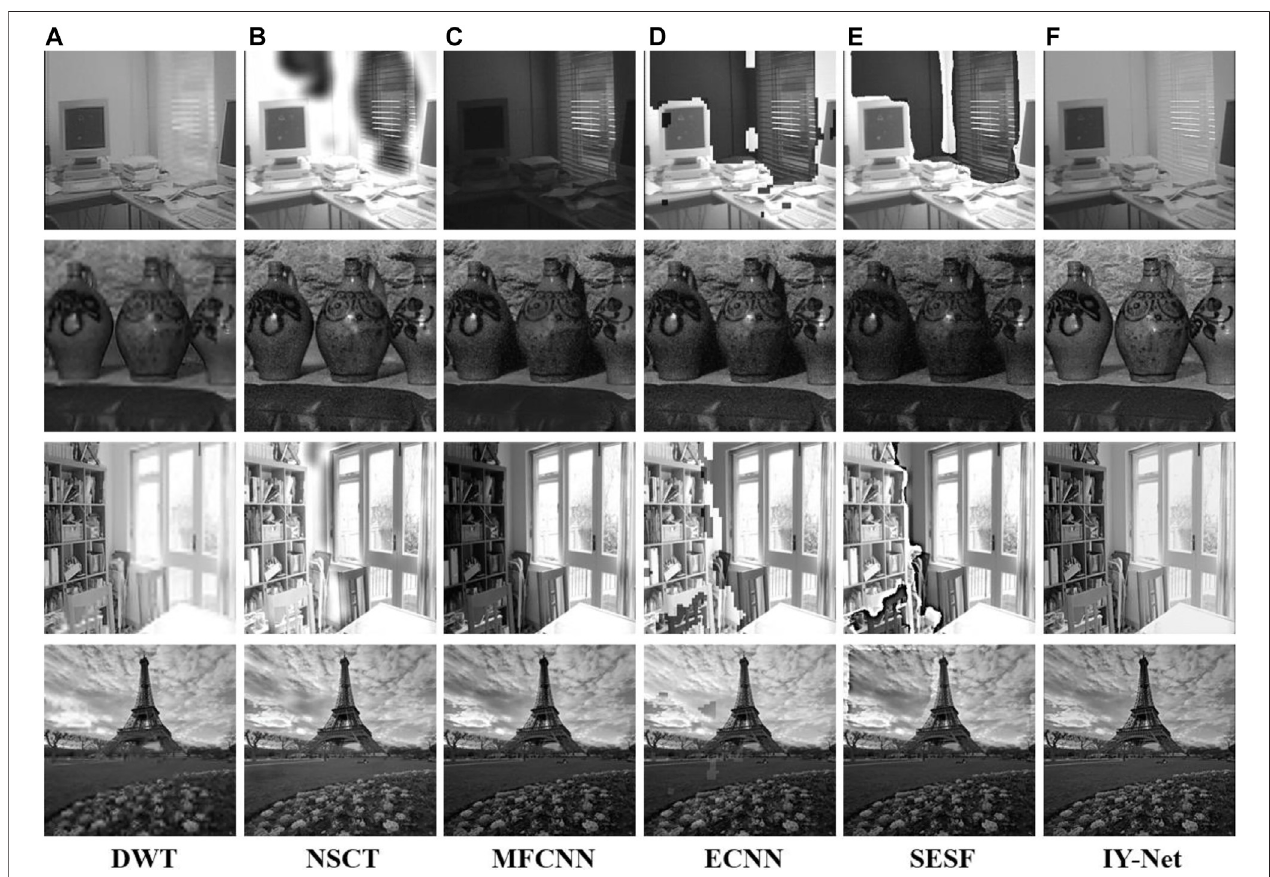
FIGURE 8 | Experiment on 4 pairs of multi-exposure images. (A) DWT, (B) NSCT, (C) MFCNN, (D) ECNN, (E) SESF, (F) IY-Net.